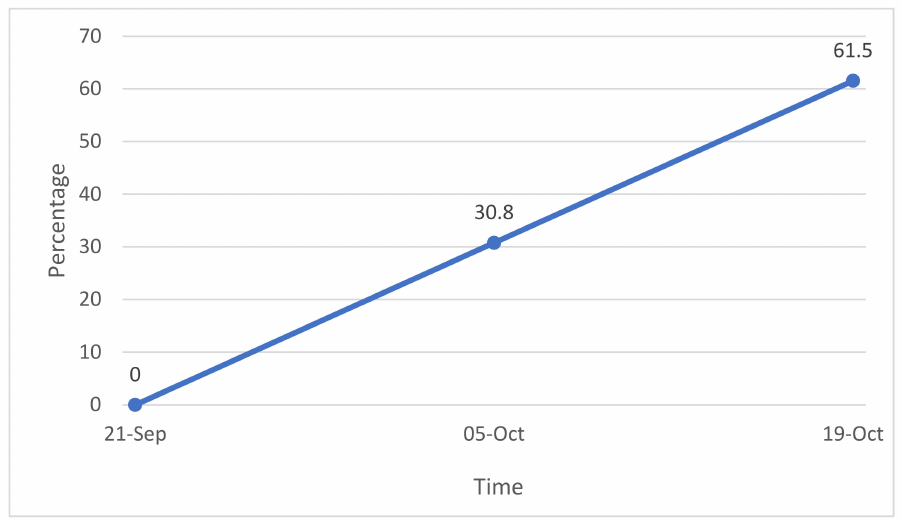
Figure 8. Linear growth of root system after 2 and 4 weeks on culture medium (BM) with IAA 10 mg L − 1 and sucrose 30 g L − 1